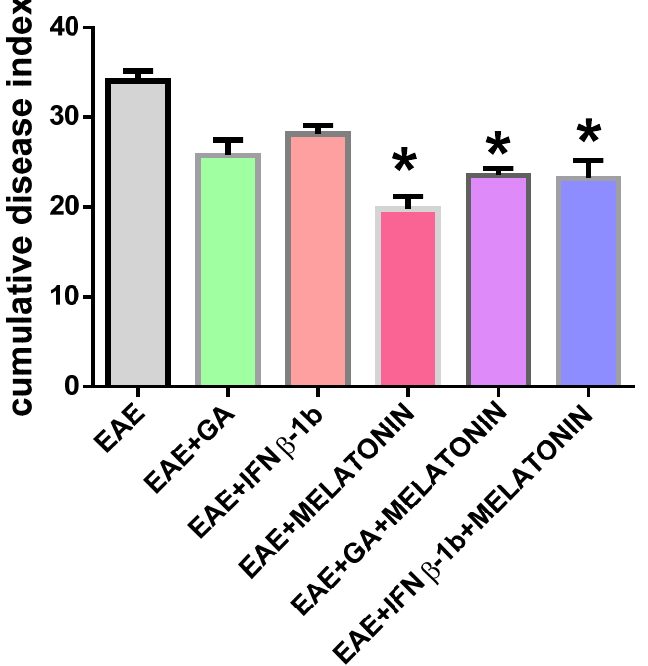
Figure 2. Cumulative disease index score. Scores are expressed as the mean ± SD. * indicates a significant difference from the EAE group ( p < 0.05).